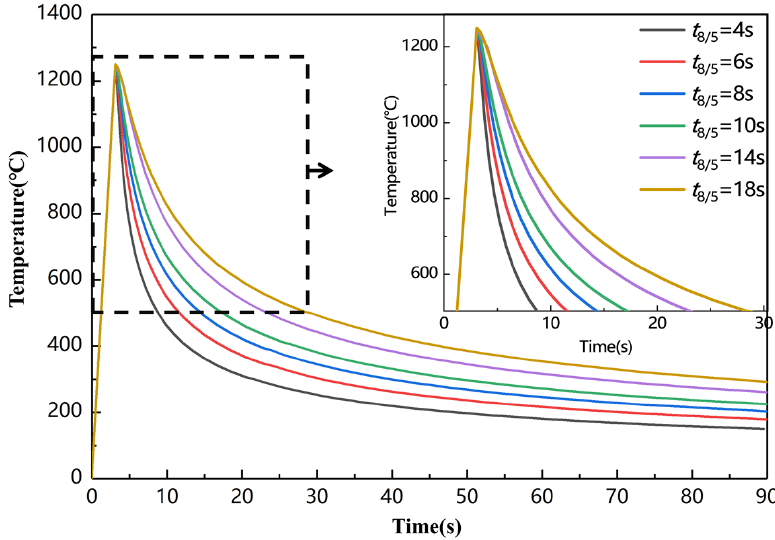
Figure 3. Test thermal cycle curves at different t 8/5 values of T max = 1250 °C.